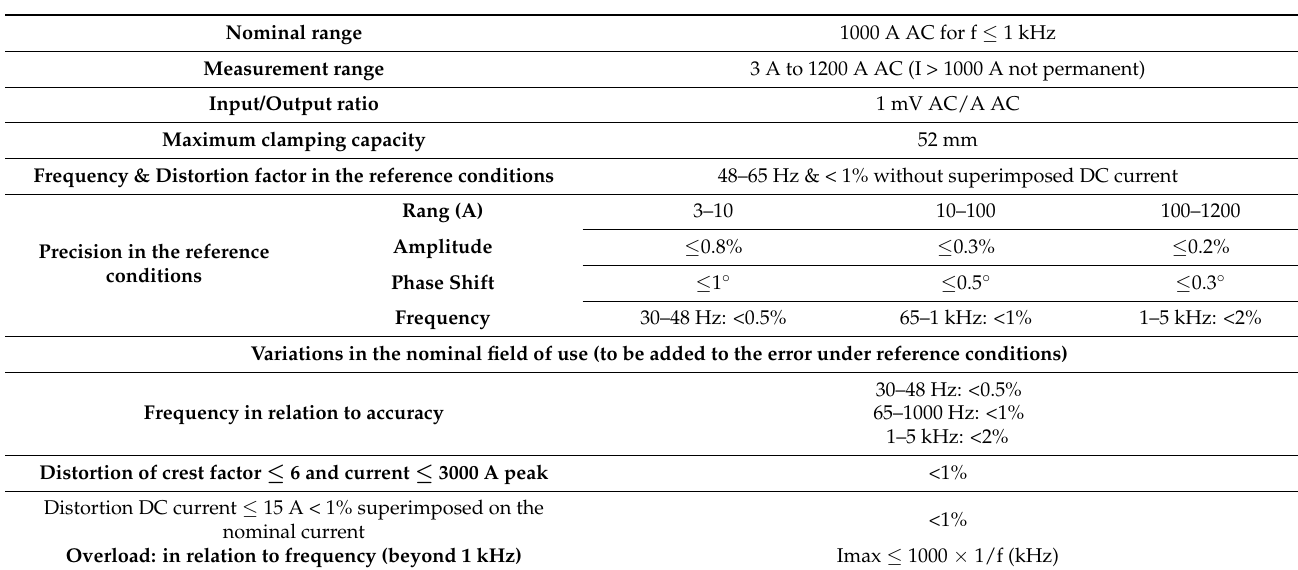
Table 5. Electrical characteristics of the C193 current sensor.